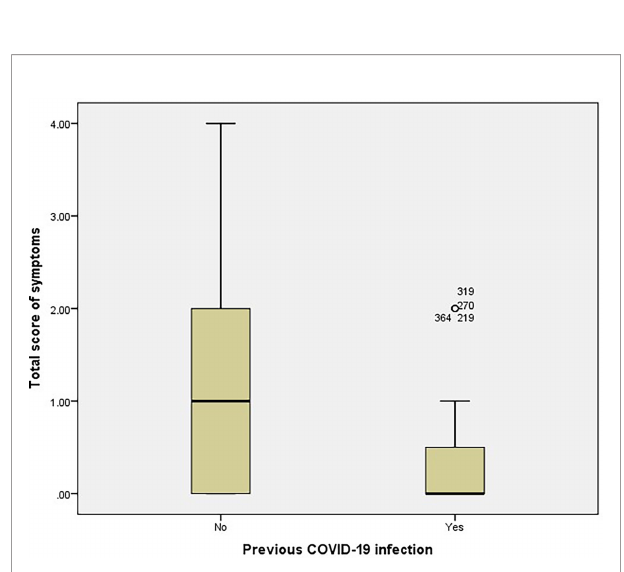
FIGURE 3 | Total score of vaccine-related symptoms among males and females (n= 365).